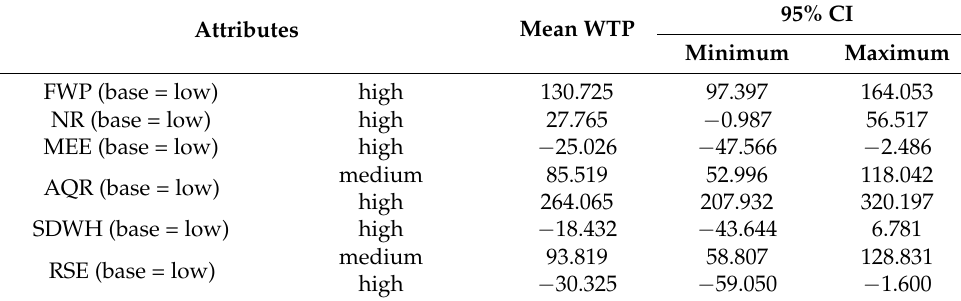
Table 12. Calculated willingness-to-pay (WTP) for municipality tax for various ESs.